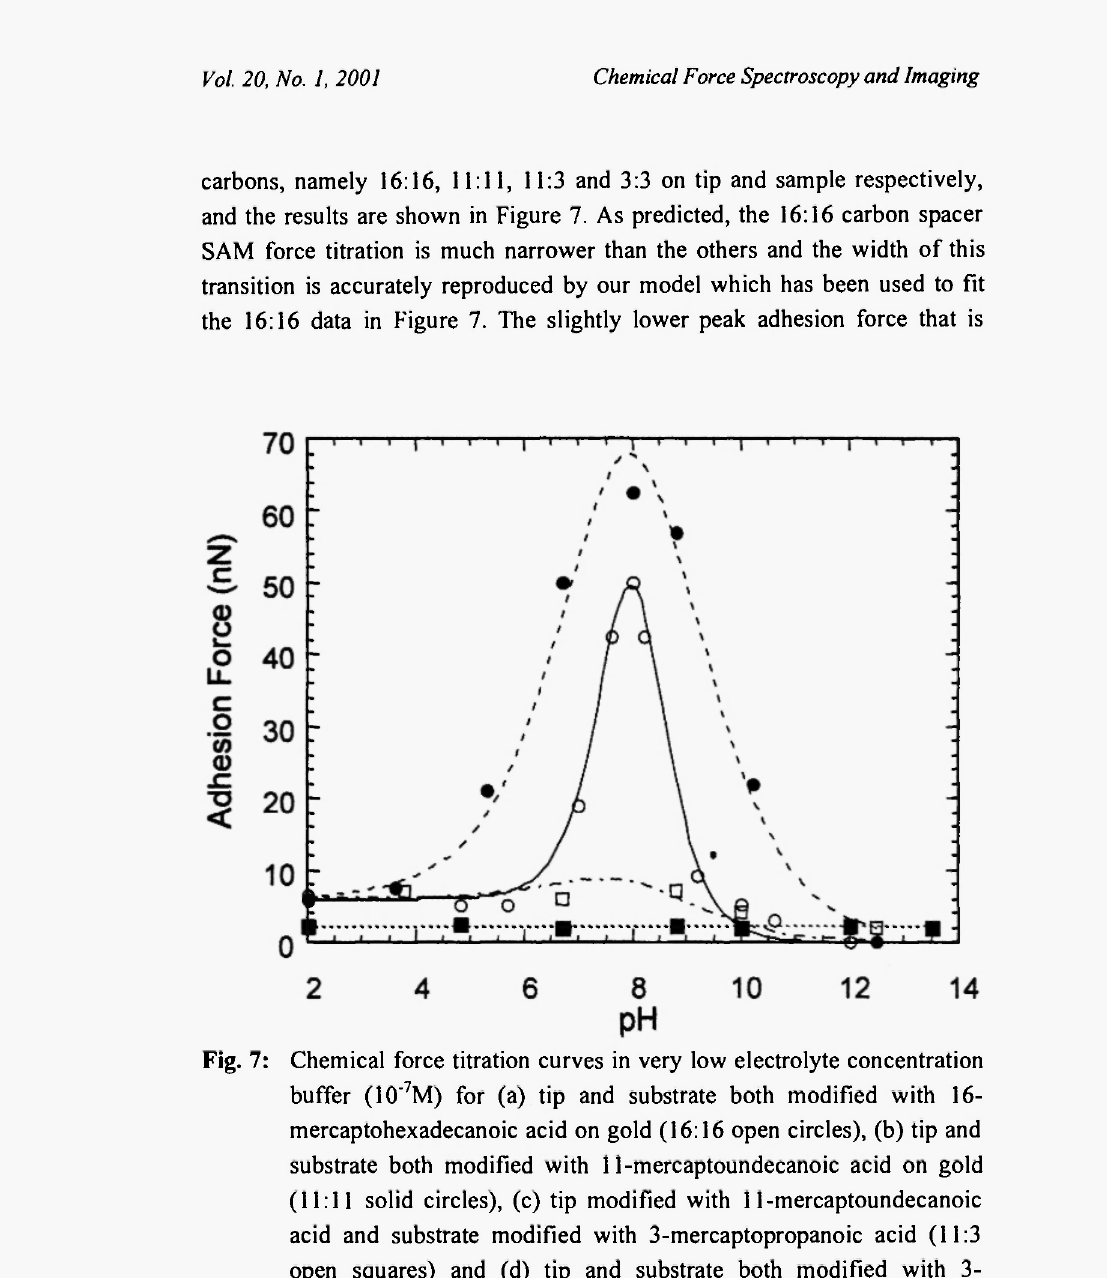
Fig. 7: Chemical force titration curves in very low electrolyte concentration buffer (10" 7 M) for (a) tip and substrate both modified with 16- mercaptohexadecanoic acid on gold (16:16 open circles), (b) tip and substrate both modified with 11-mercaptoundecanoic acid on gold (11:11 solid circles), (c) tip modified with 11-mercaptoundecanoic acid and substrate modified with 3-mercaptopropanoic acid (11:3 open squares) and (d) tip and substrate both modified with 3- mercaptopropanoic acid (3:3 solid squares). The simple model of figure 6 reproduces the shape of the titration curves but not the width of any but the longest alkyl spacer monolayers due to disorder in the shorter alkyl spacer SAMs. (Curves through the 11:11, 11:3 and 3:3 data are only a guide to the eye, but the 16:16 peak is accurately fitted by the model yielding a value of m of